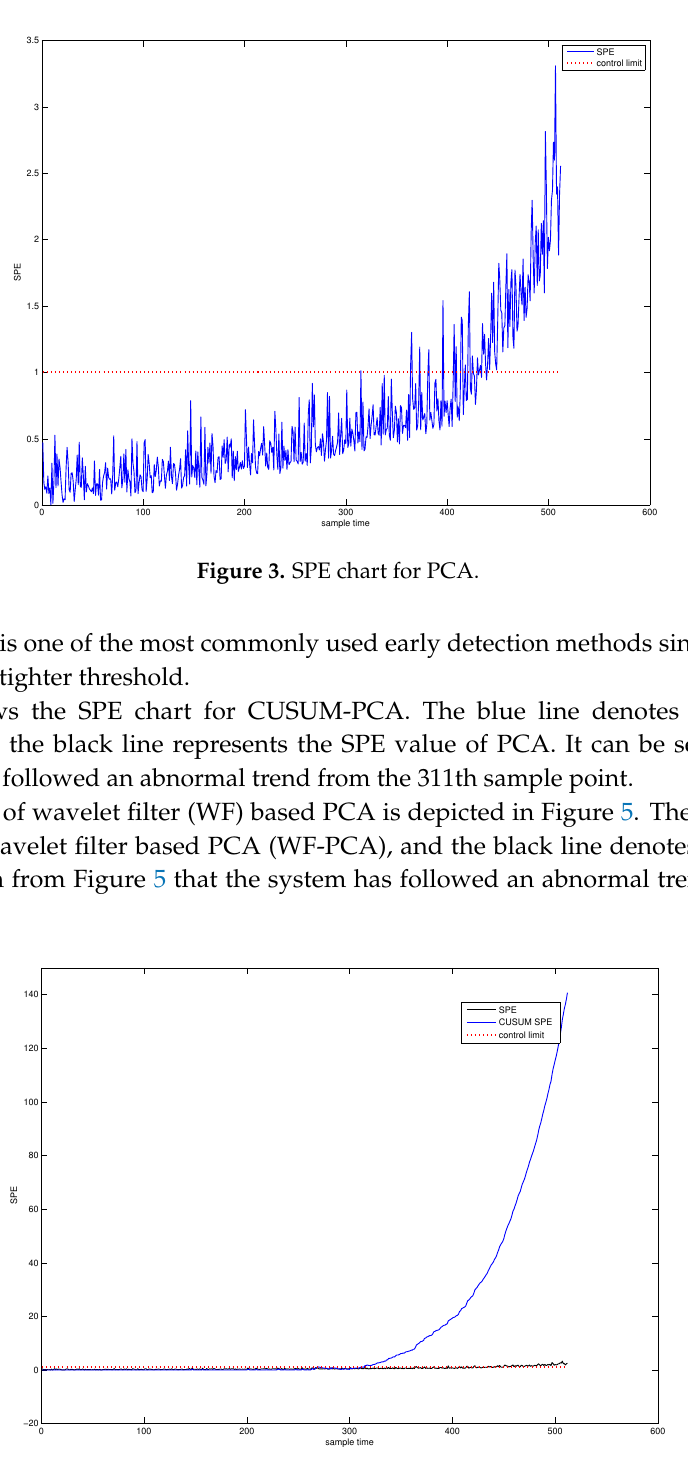
Figure 4. SPE chart for